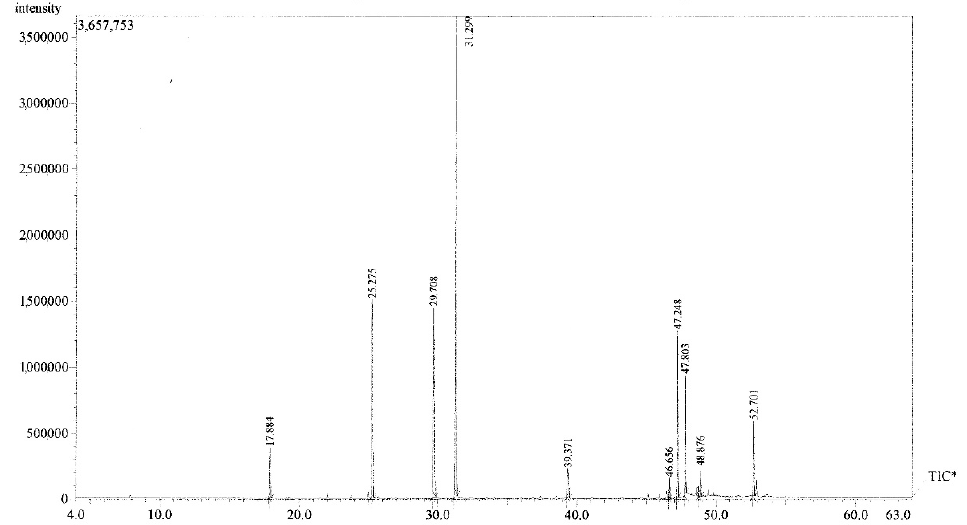
Figure 1. GC/MS chromatogram of the essential oil of C. winterianus with total ion current (TIC) peak reports. * Total Íon Current. Table 1. Chemical composition (%) of the essential oil of C. winterianus .